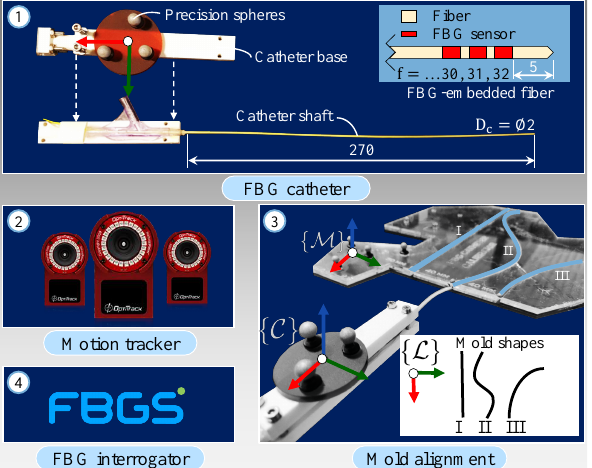
Figure 2. Assembly and calibration protocol for the Fiber Bragg Grating (FBG)-embedded catheter: 1 32 FBG sensors are inside a multicore fiber that is inserted in, and fixed to, the catheter shaft. The catheter base has a known offset with respect to the first sensor ( f = 1). 2 A rigid body precision sphere tool on the catheter base is tracked by eight infrared cameras that surround the Advanced Robotics for Magnetic Manipulation (ARMM) workspace. 3 A mold containing three channels with ) is used to calibrate the shape of the catheter to its base, ( ) known coordinates in local frame ( {L} {C} ) . Frame recorded in the global reference frame ( is recorded via precision-spheres to obtain {G} {M} the pose of the mold. The straight channel (I) acts as a reference with a zero strain shift of the FBG fiber. The second channel (II) is used to calculate the transformation ( H M ). The final channel (III) is used L to validate the global transformation between the FBG coordinates streamed by 4 , the interrogator and both the local channel shape ( H G ), and catheter base frame ( H G ). This information is combined M C to display the catheter shape in real-time. All dimensions are in